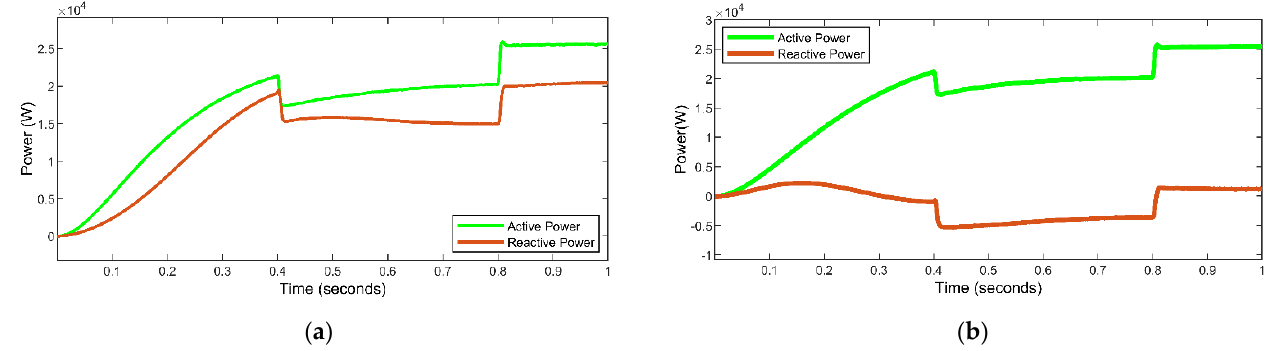
Figure 9. When the parameters change greatly, the output of active and reactive power: ( a ) DG1; ( b ) DG2.